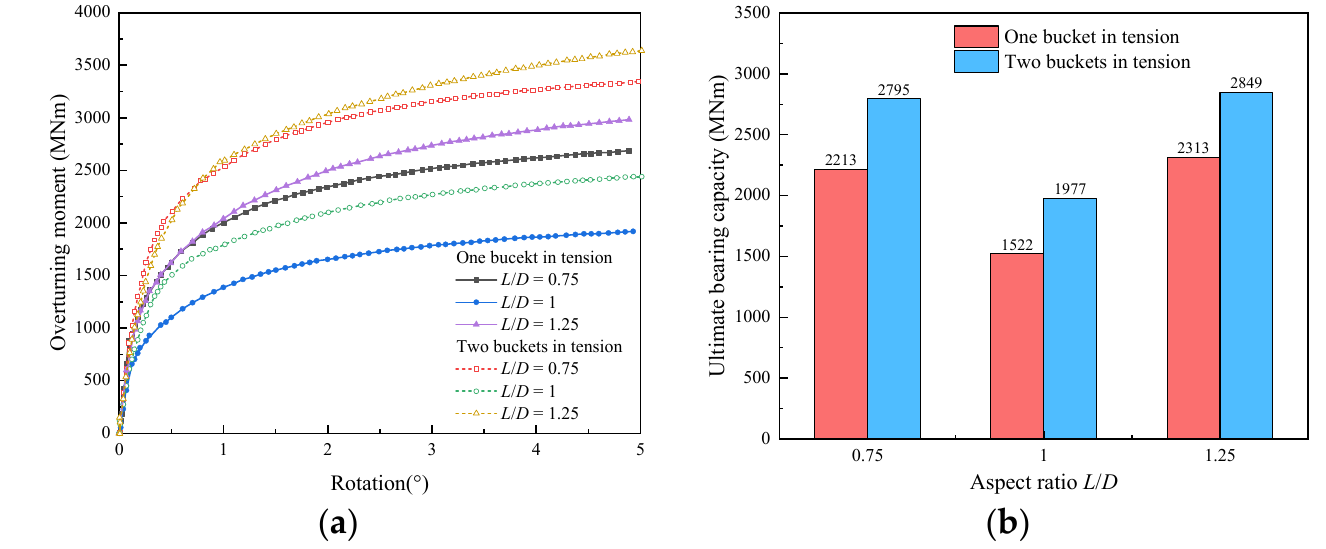
Figure 13. Anti-overturning bearing characteristic in sand: ( a ) moment-rotation response, ( b ) ultimate bearing capacity. Likewise, the overturning moment-rotation curves of the foundation with varied aspect ratios in the soft clay are compared in Figure 14a. Different from the scenario in sand, the bearing capacity of the foundation in soft clay under OBT is greater than that under TBT. It indicates that the unfavorable loading direction of the foundation in clay should be carefully confirmed with the avoidance of overlapping between the main wind/wave direction and the TBT. This finding is consistent with the engineering experience obtained from the application of tripod bucket jacket foundations in the South China Sea [39].